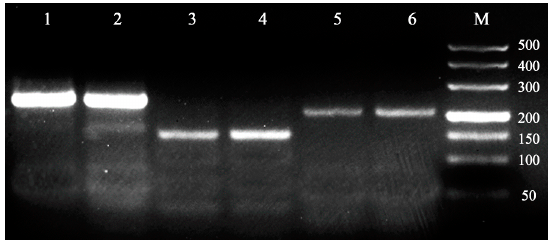
Figure 1. Gel electrophoretogram showing the effectiveness of three microsatellite loci (C6, C22, C31) in C. fulvus and E. japonica , with 1, 3, 5 for C. fulvus , and 2, 4, 6 for E. japonica . M: DL500 bp DNA